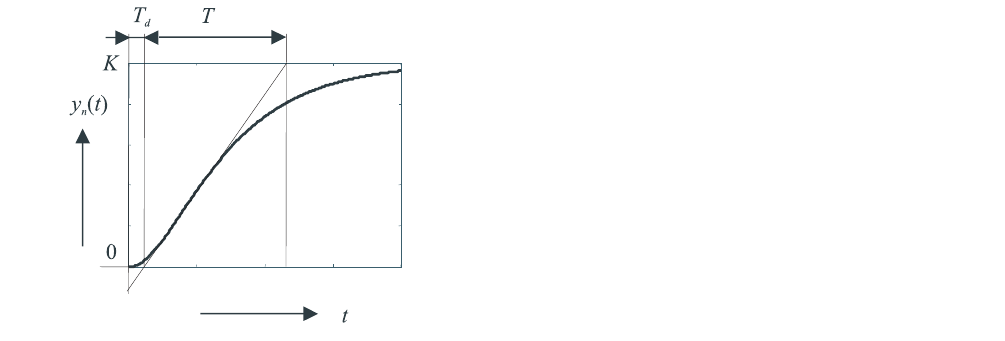
Figure 3. Approximation of a normalized stable step response based on a tangent drawn through the inflation point according to Ziegler and Nichols